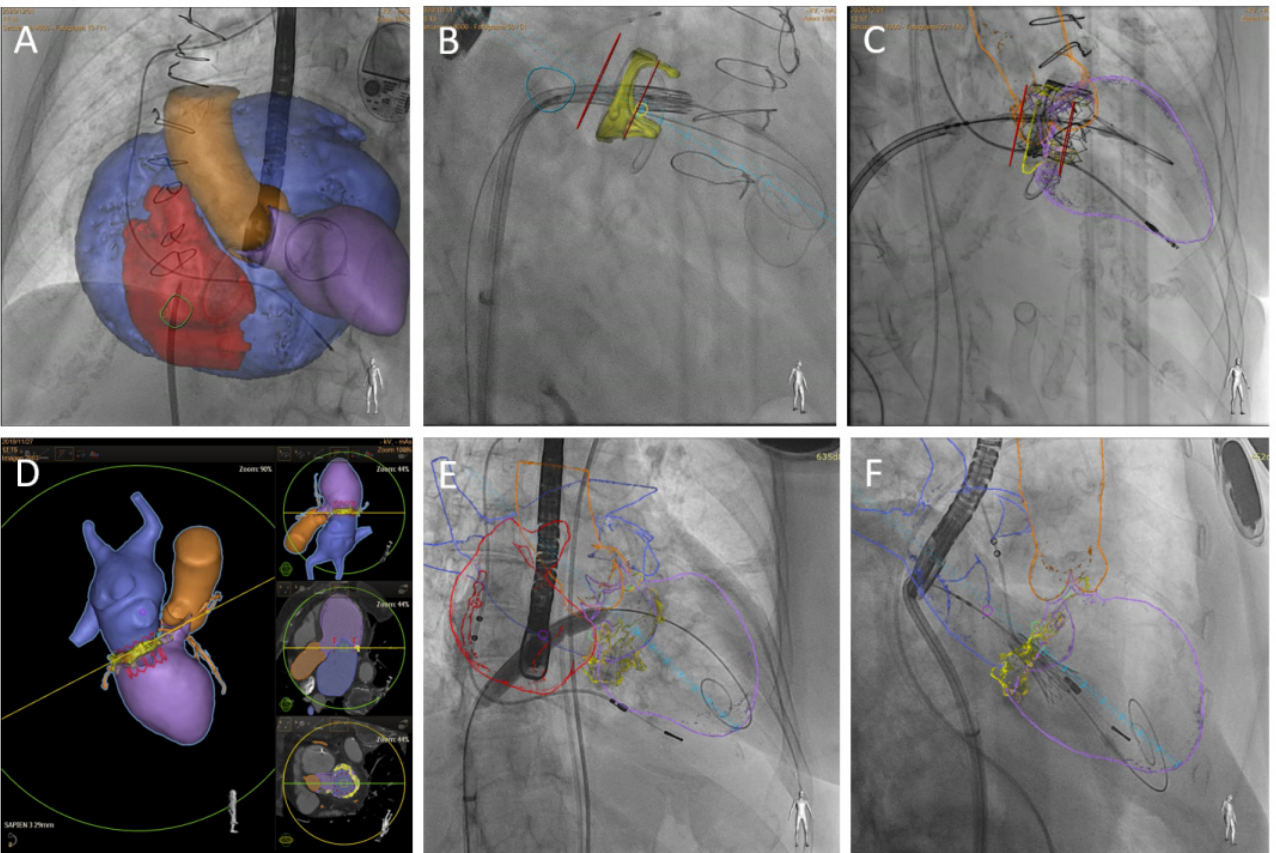
Figure 2. CT-fluoroscopy fusion imaging. The superior row shows a TMVR valve-in-valve procedure in a patient with extreme left atrium enlargement and modified projection required for transeptal puncture ( A ). Markers (red lines) may be over-imposed to fluoroscopy imaging to guide depth deployment ( B , C ). Inferior row, TMVR valve-in-MAC CT preprocedural planning ( D ), interatrial septal balloon dilatation ( E ) and initial phase of THV deployment with coaxial projection to mitral annulus ( F ).